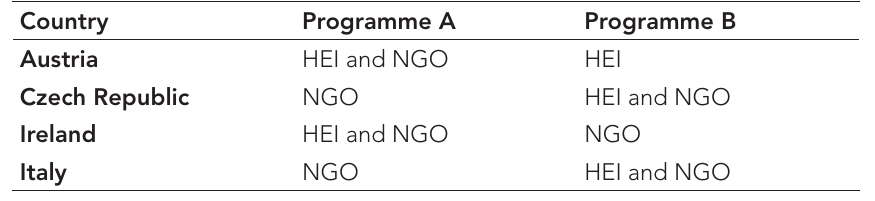
Table 2: Teacher education providers across European